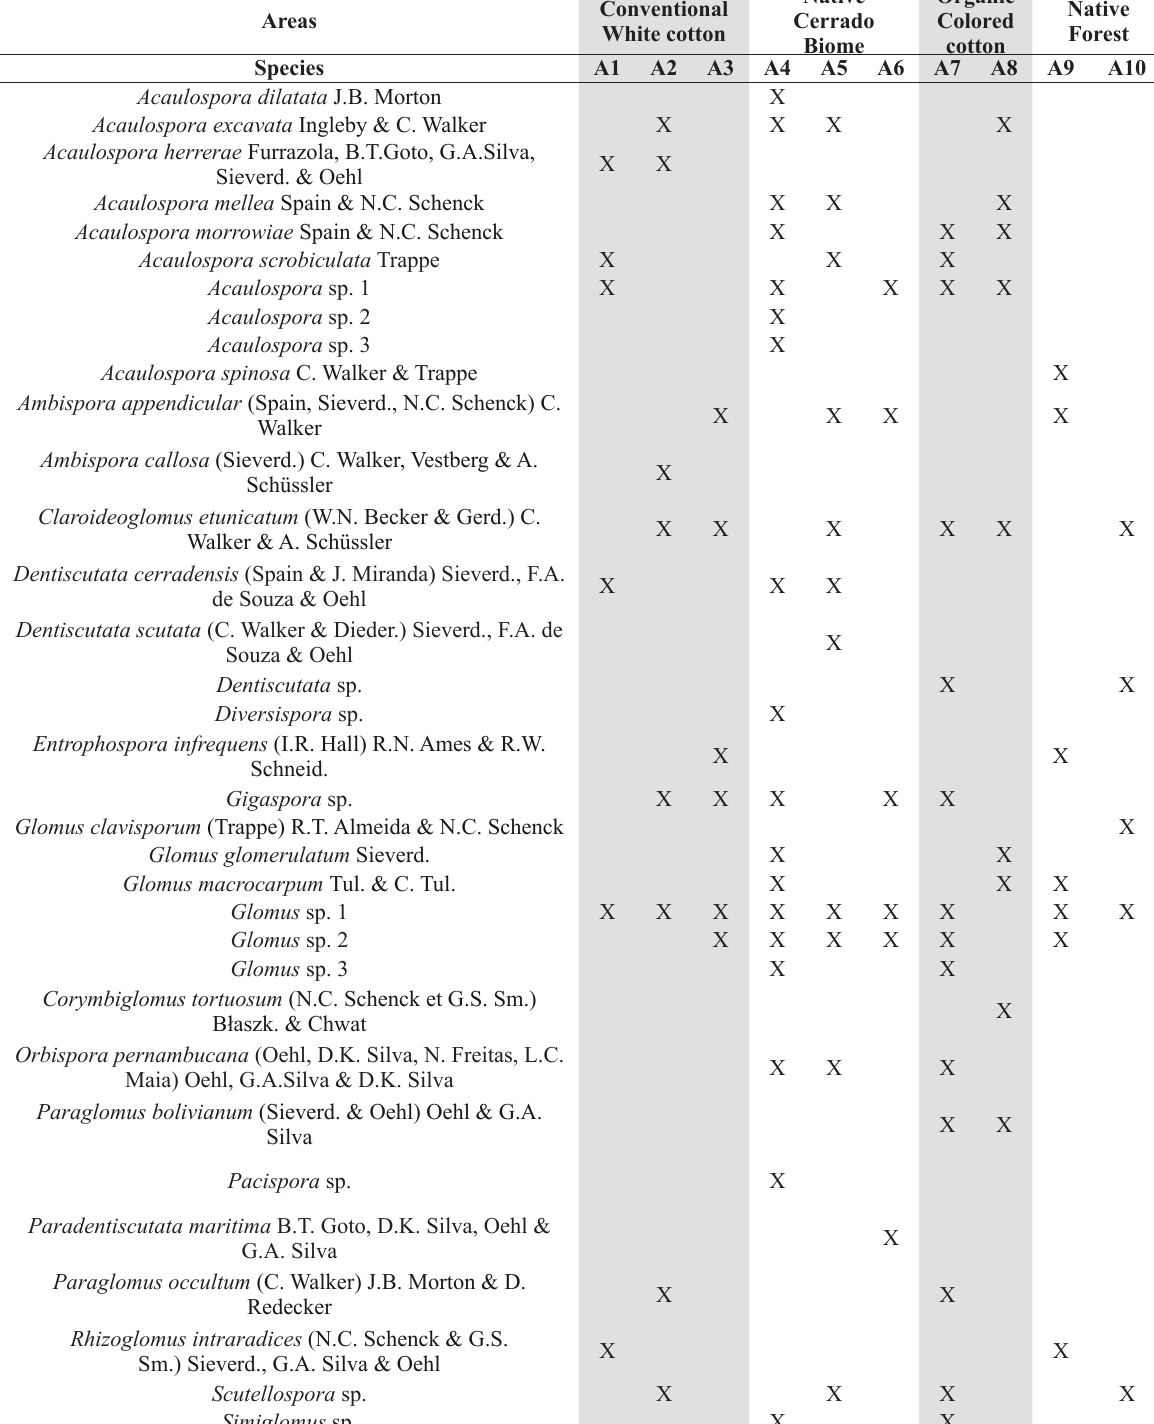
TABLE III Arbuscular mycorrhizal fungi in cotton growing areas under crop management systems, native biomes, and trap cultures. Conventional Areas White